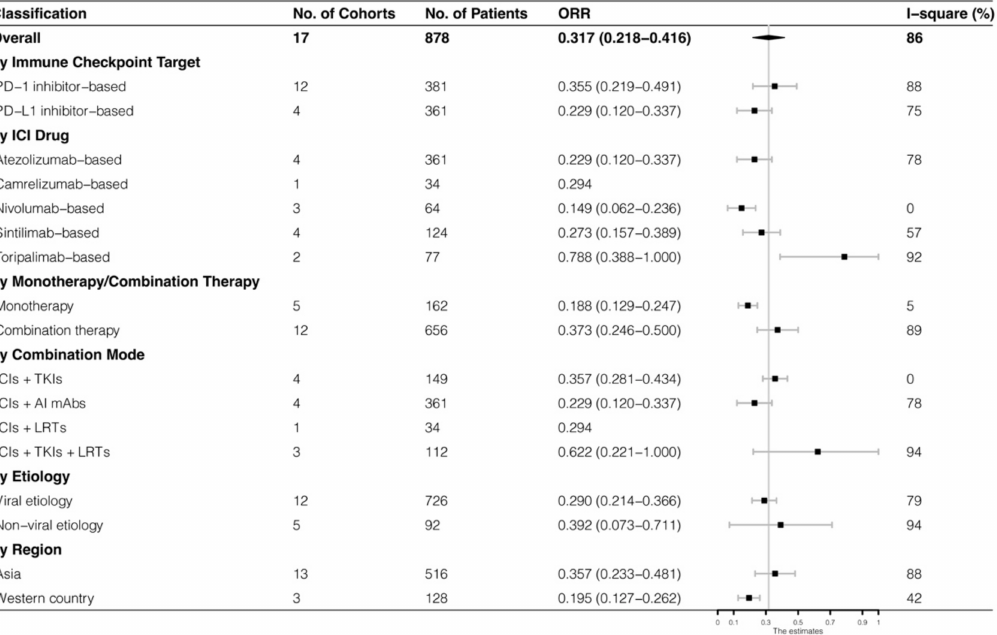
Figure 5. Subgroup analysis of ORR judged by RECIST 1.1.